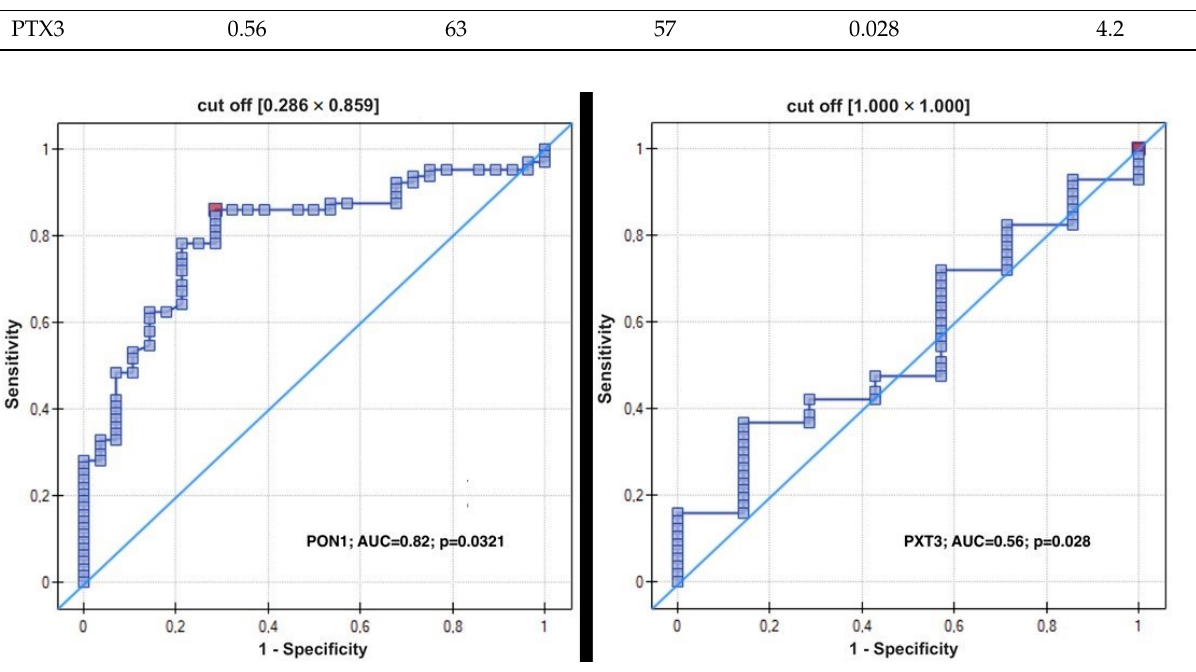
Figure 2. (ROC) Curve using PON1 ( left ) and PTX3 ( right ) Distinguishing between endometrial cancer and normal endometrium .